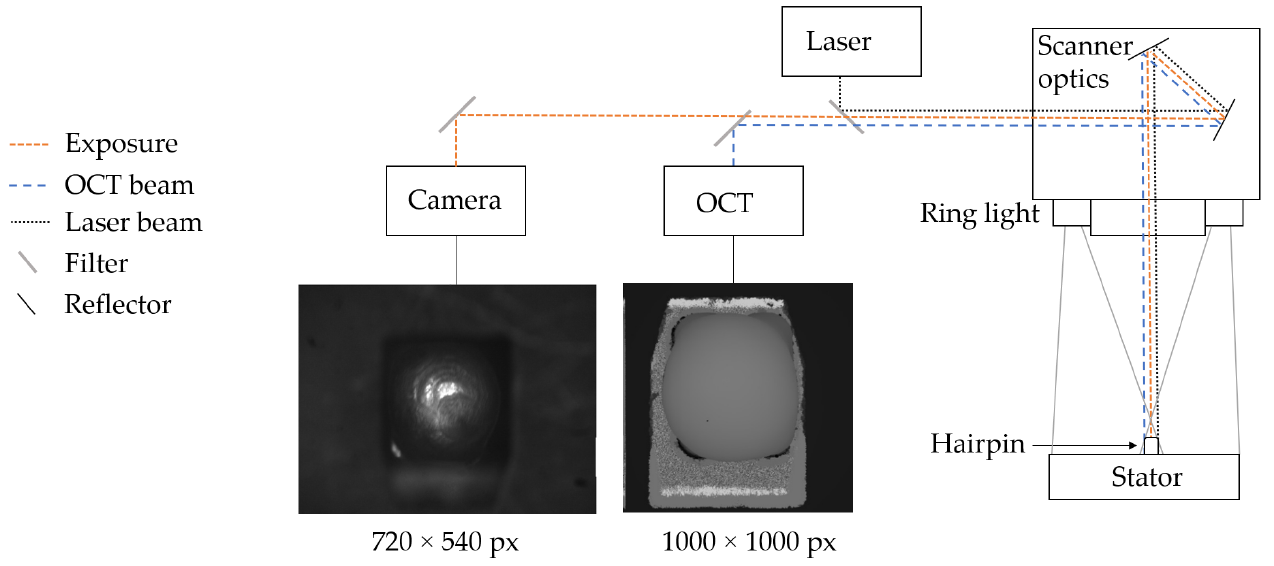
Figure 1. Experimental setup for hairpin data